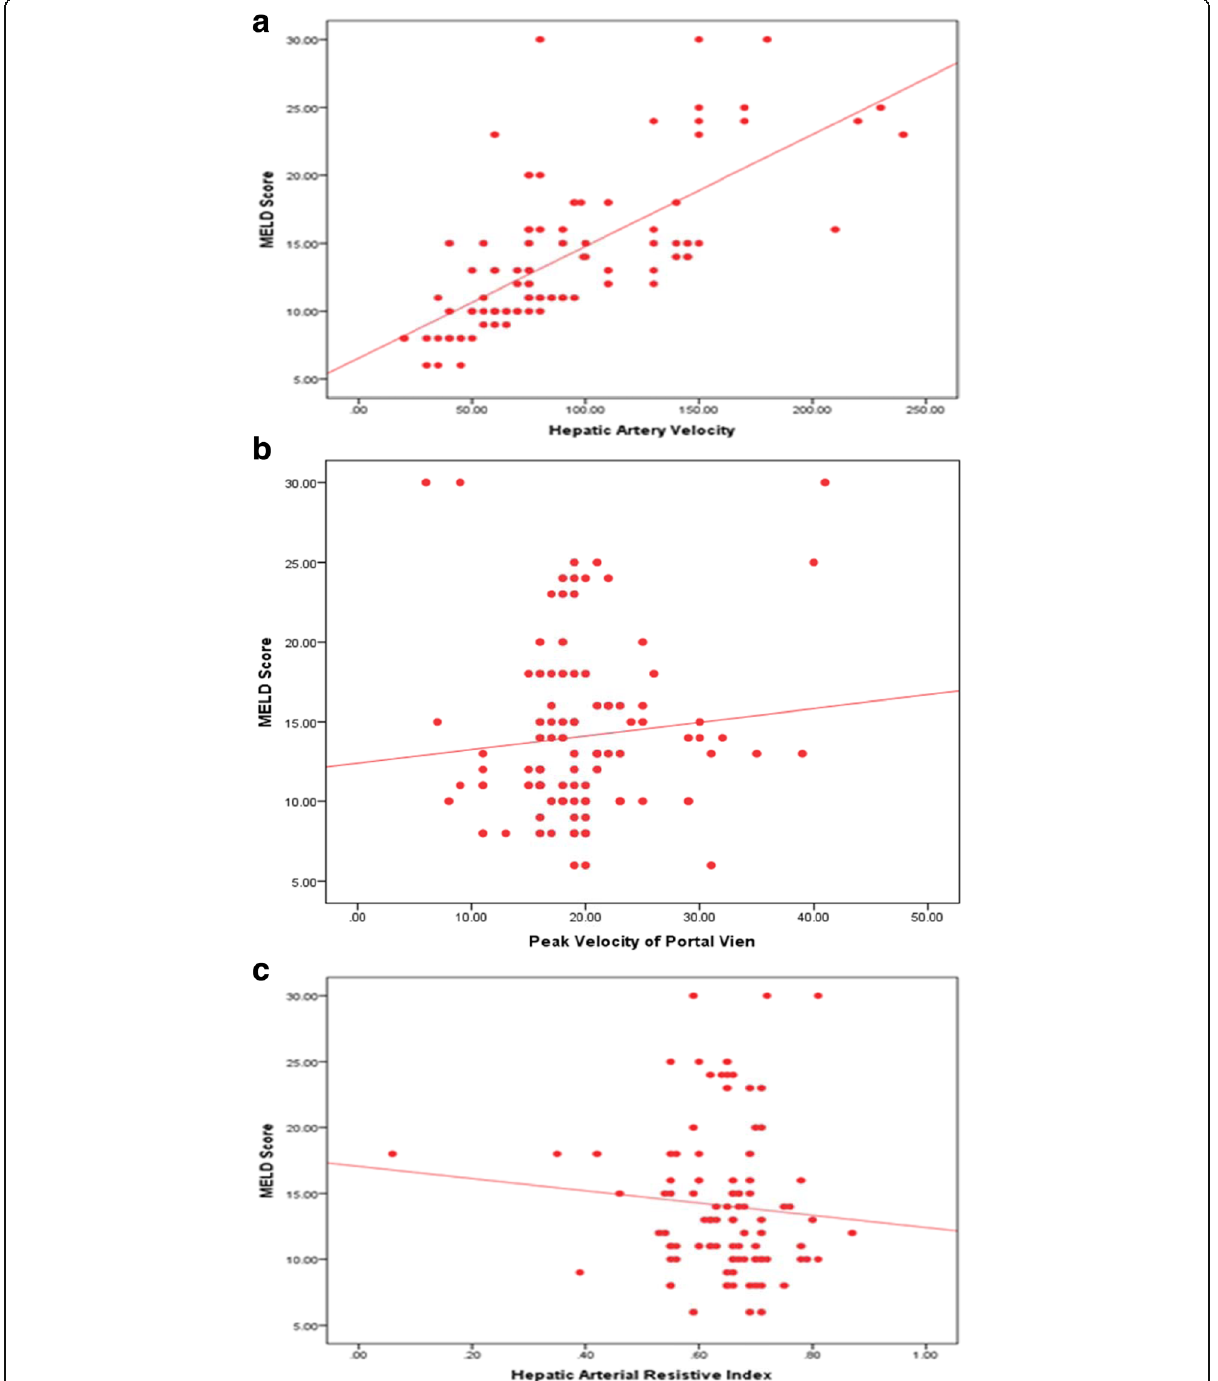
Fig.1 a Scatter plot of MELD score as a function of HAV (cm/s), the solid line represents the best-fit linear regression. b Scatter plot of MELD score ( y -axis) as a function of PVV (cm/s) ( x -axis). The solid line represents the best-fit linear regression. c Scatter plot of MELD score ( y -axis) as a function of HARI ( x -axis). The solid line represents the best-fit linear